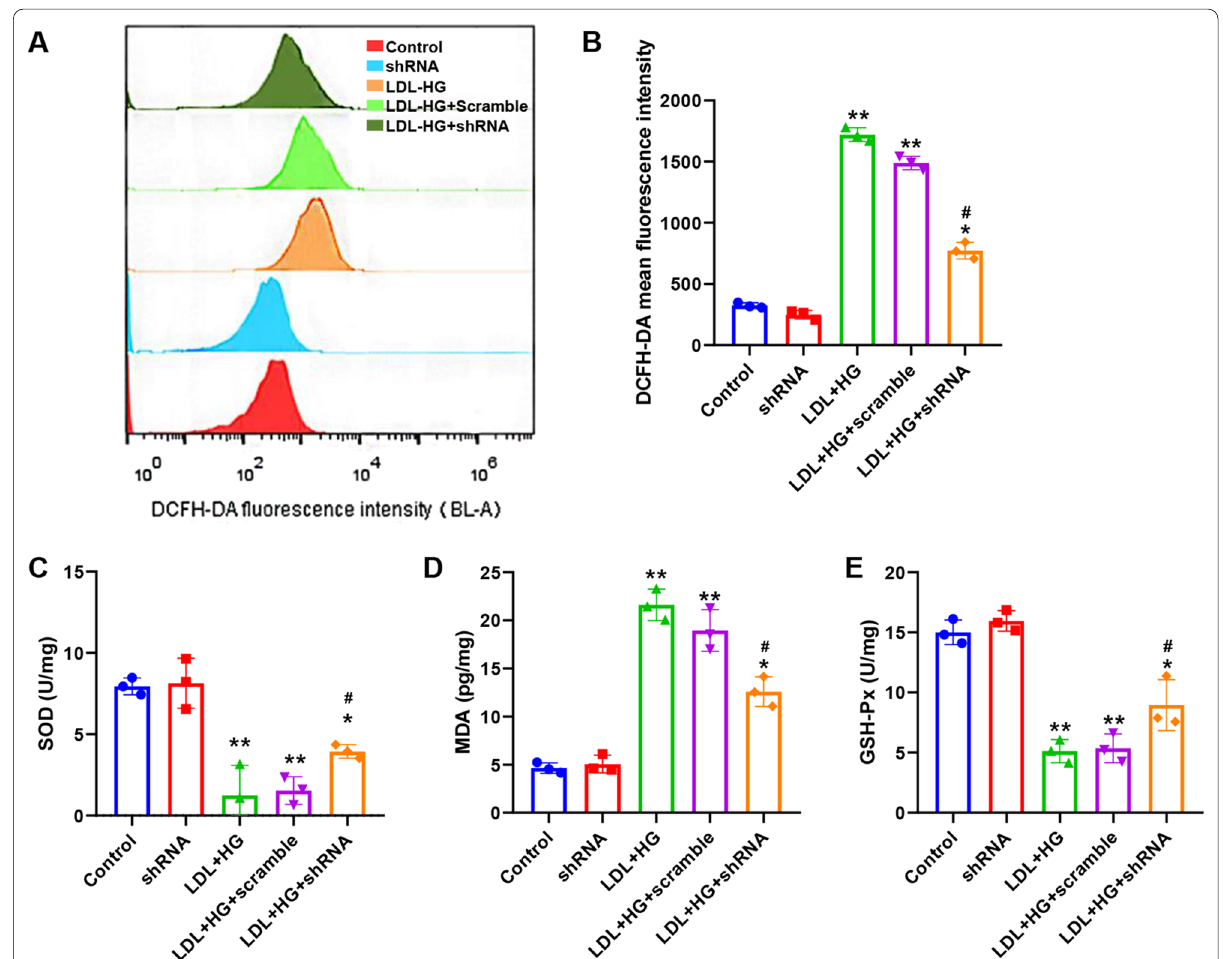
Fig. 7 Effect of silencing miR-351 on the oxidative stress level of cells. A The intensity of the DCFH-DA probe was detected by flow cytometry to reflect the ROS level of cells. B Quantification of flow cytometry results. C Results of SOD level detection in cells. D Results of MDA level detection in